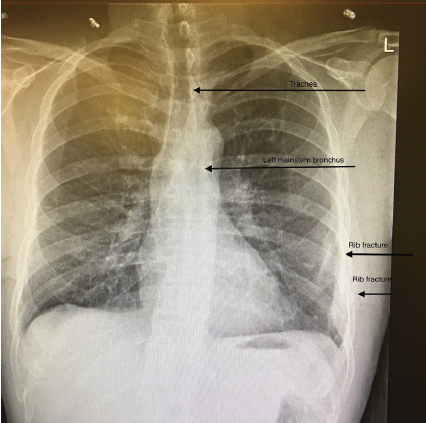
Figure 4: Chest radiograph from day 28 demonstrating the normal airway anatomy as well as the two left rib